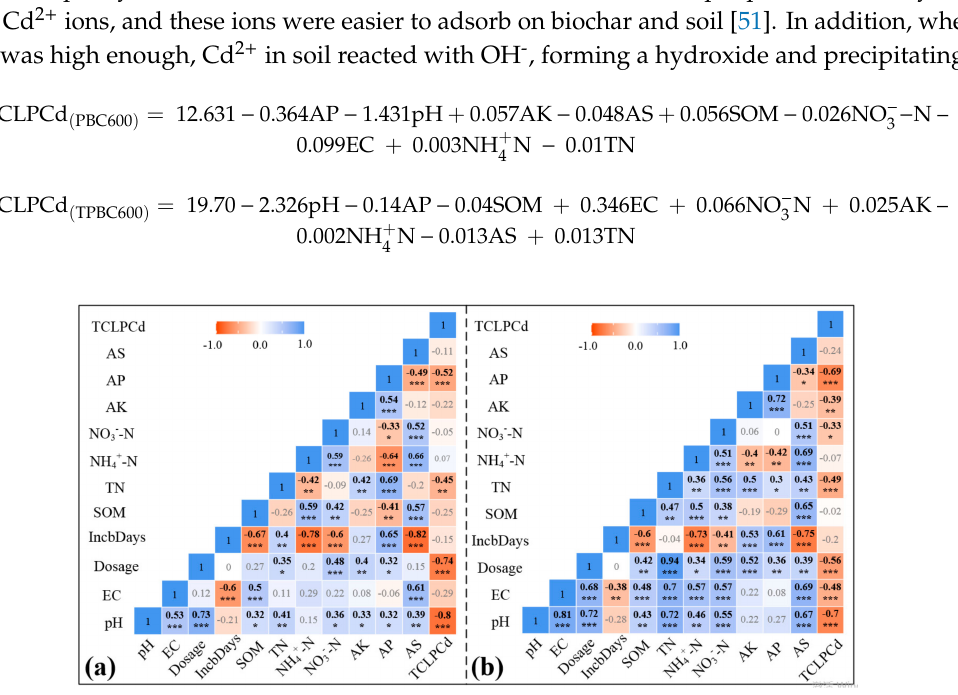
Figure 4. Pearson correlation matrixes for the relationships between physical and chemical properties of the soils, incubation days, biochar dosages, and availability of Cd in the soils. ( a ) PBC600; ( b ) TPBC600. * indicates that p < 0.05 (significant); ** indicates that p < 0.01 (very significant); *** indicates that p < 0.001 (extremely